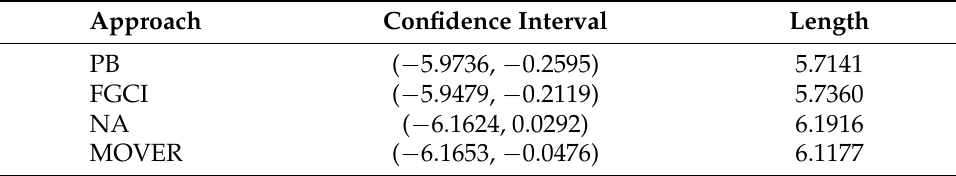
Table 7. The 95% confidence intervals for η based on the proposed